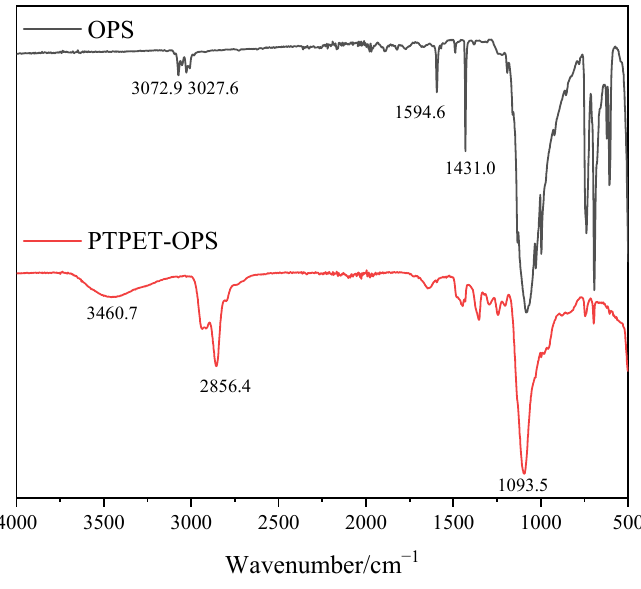
Figure 8. FT-IR analysis of PTPET-OPS. The FT-IR spectrum of the prepared PTPET-PhVPOSS is shown in Figure 9. The absorption peak at 3073.2 cm − 1 is the stretching vibration peak of the =C-H group in the benzene ring. The absorption peaks at 1594.6 cm − 1 and 1430.3 cm − 1 are the stretching vibration peaks of the C=C carbon skeleton in the benzene ring. The absorption peaks at 1026.5 cm − 1 and 1090.1 cm − 1 are the absorption peaks of Si-O-Si. Due to the induced effect of phenyl and vinyl groups in the surrounding chemical environment, Si-O-Si appears as double peaks in FT-IR. The absorption bands at 693.7 cm − 1 and 727.1 cm − 1 are the out-of- plane bending vibration peaks of the vinyl group and C-H in the benzene ring. For PTPET- PhVPOSS composites, except for the -OH group at 3414.0 cm − 1 and the antisymmetric and symmetric stretching vibration peaks of -CH 2 at 2937.4 cm − 1 and 2856.2 cm − 1 that exist in the PTPET structure, there are still stretching vibration peaks that represent the structure of Si-O-Si from PhVPOSS.